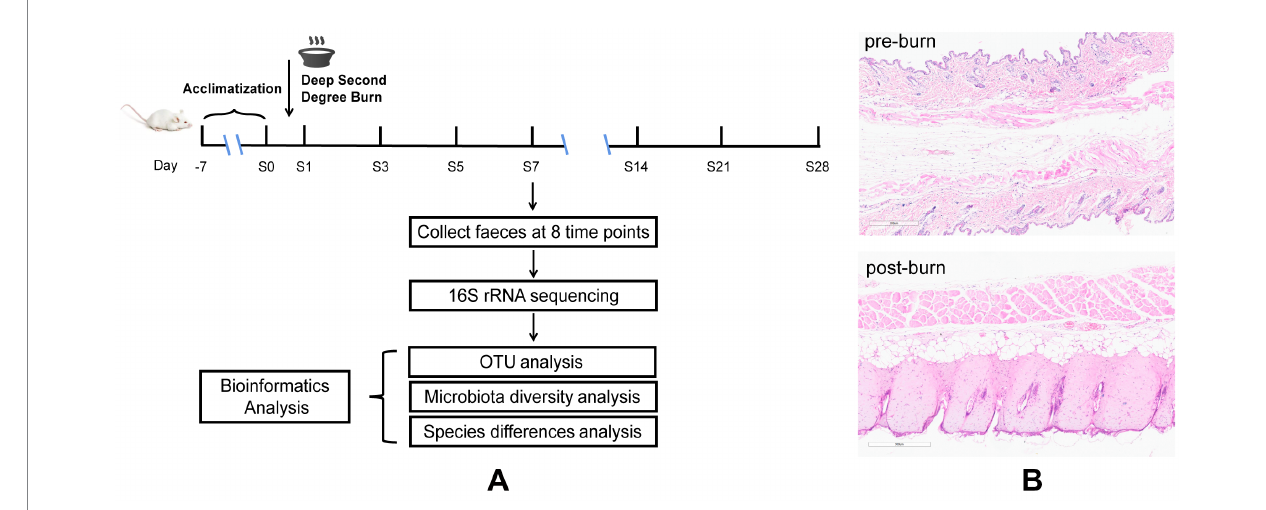
FIGURE 1 Diagrammatic sketch of the experimental protocol (A) , H&E for skin tissues before and after burn (B)